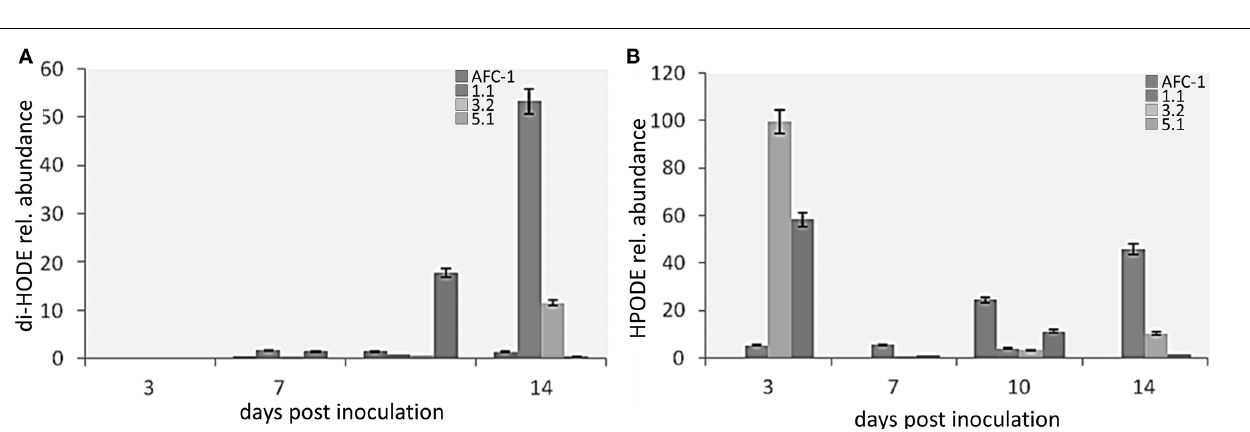
FIGURE 9 | Results in the production of (A) di-HODE and (B) HPODE in maize inoculated with the mutant strains or with AFC-1, 3, 7, 10, and 14 days post inoculation, compared to non-inoculated maize. The results represent the average of six repetitions arising from two different experiments ± SE.